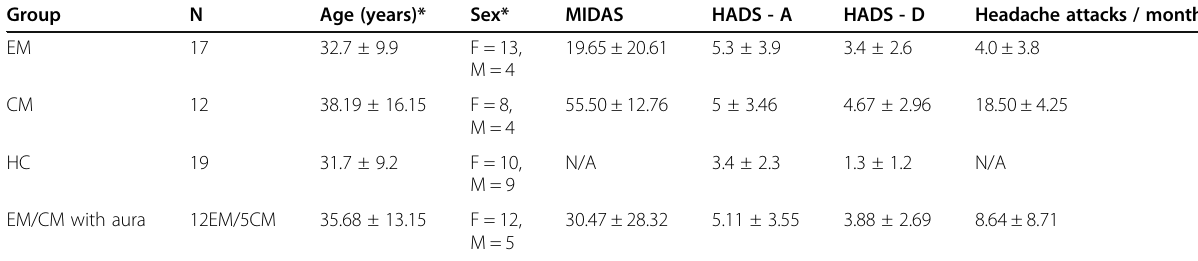
Table 1 Demographic details of the subjects in the study Group